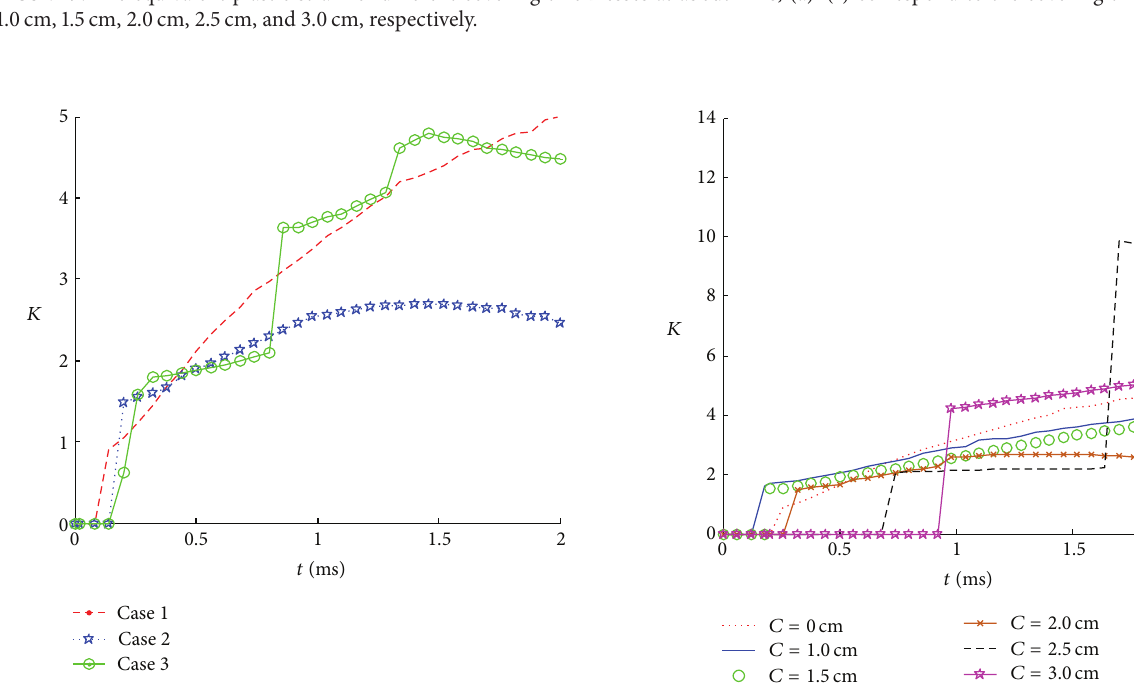
3a–3c. The failure modes of double cylindrical shell coated on different surfaces are shown in Figures 16 and 17.